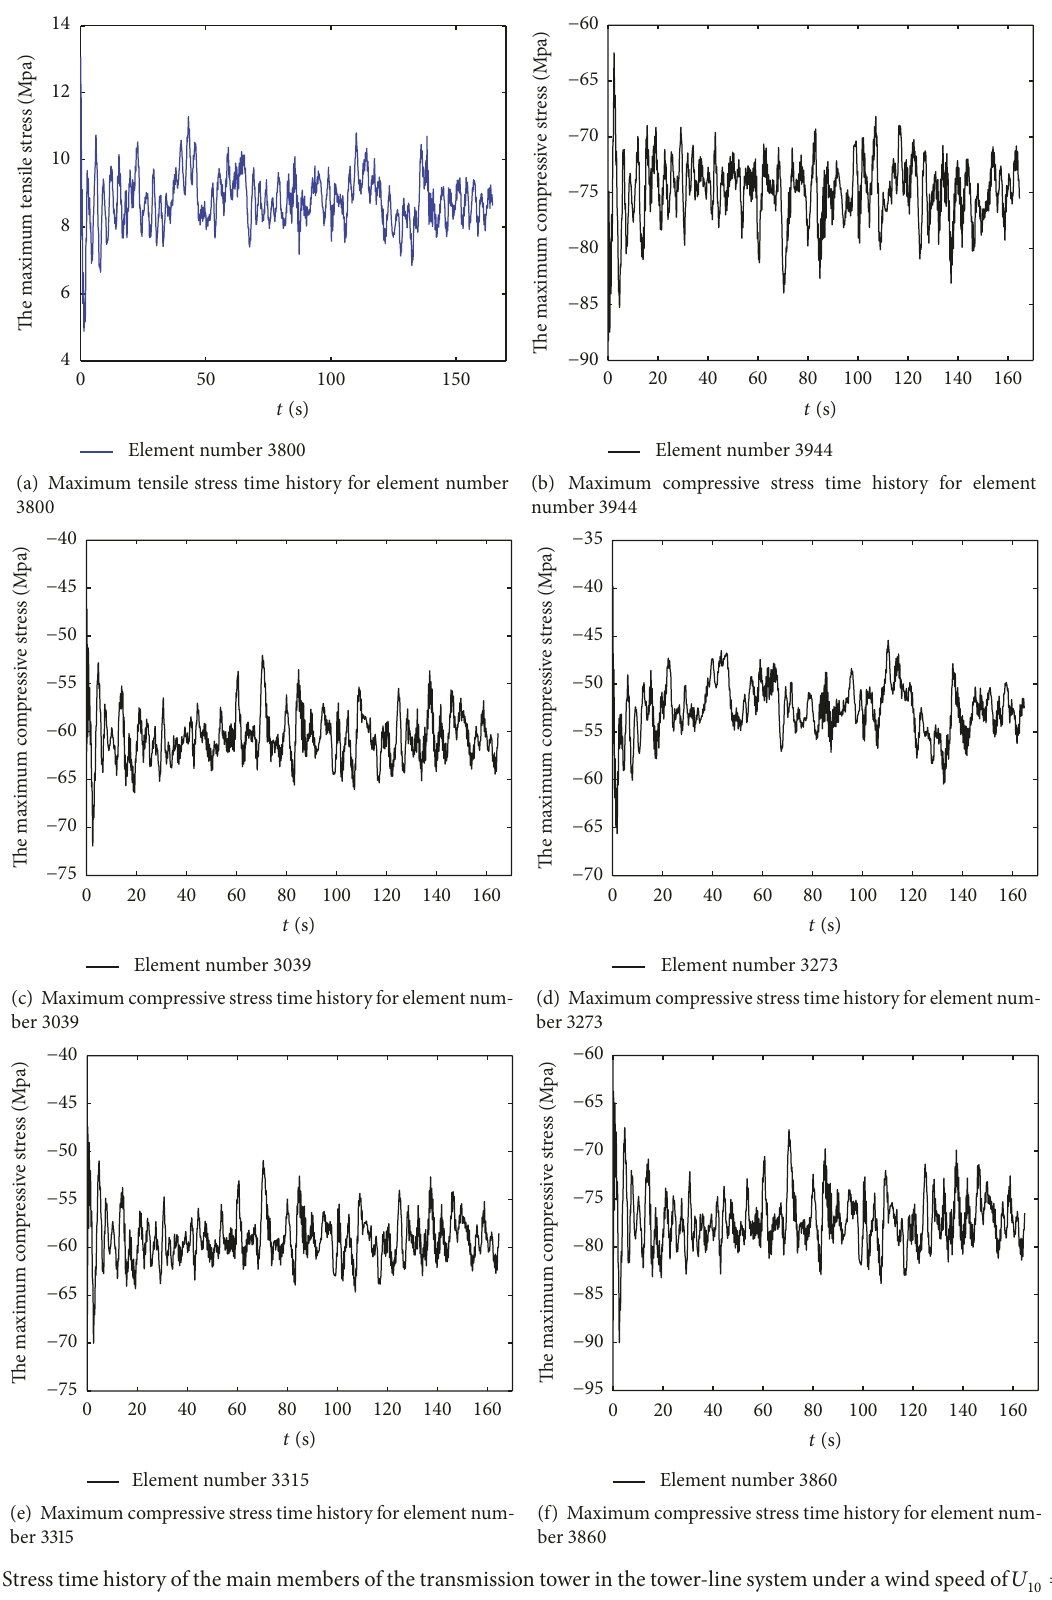
Figure 18: Stress time history of the main members of the transmission tower in the tower-line system under a wind speed of 𝑈 10 = 6.03